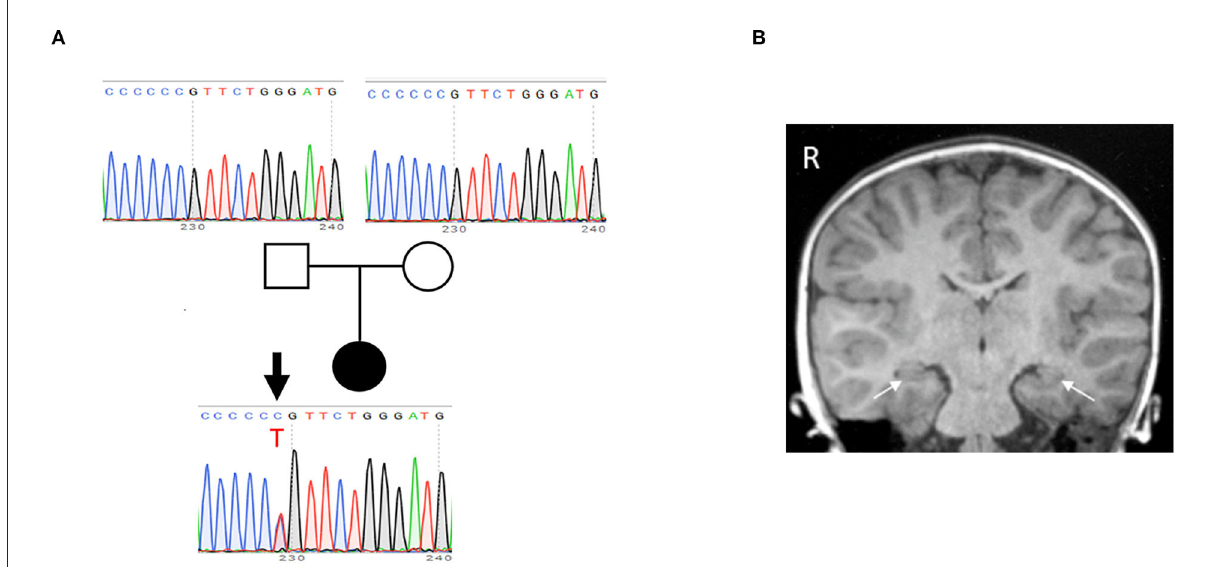
FIGURE1 Identification of de novo P212L mutation in CAMK2A from a patient with ID and ASD. (A) The pedigree and electropherogram of the proband. Whole exome sequencing reveals a de novo heterozygous c.635C > T variant, which is confirmed by Sanger sequencing. (B) A coronal T1-weighted MR image at age 5 years shows no structural and volumetric abnormality, including hippocampi